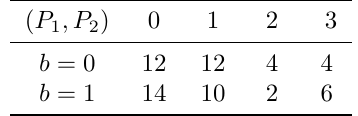
Table 3: Histogram of the joint distribution of ( P 1 , P 2 ) for b = 0 and b = 1. ( P 1 , P 2 ) 0 1 2 3 b = 0 12 12 4 4 b = 1 14 10 2